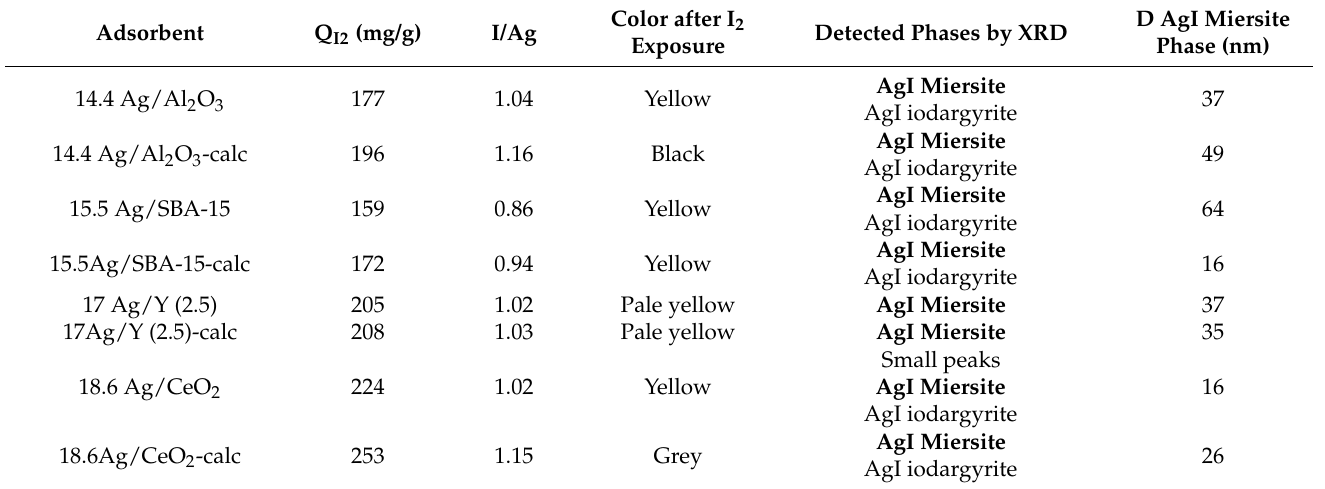
Table 2. Adsorption characteristics of the investigated calcined and non-calcined silver supports after I 2 adsorption test (the major phase is indicated in